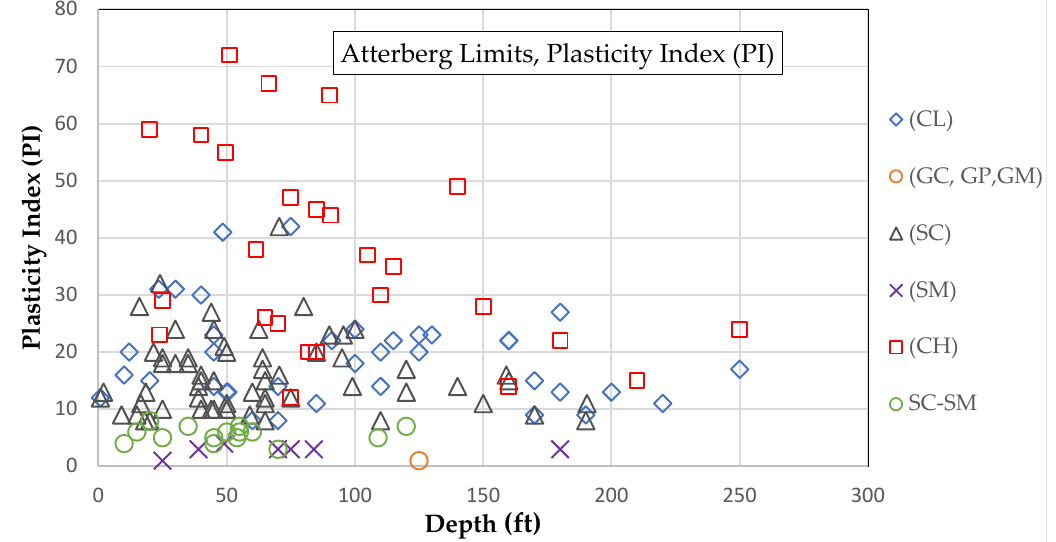
Figure 1. Measured plasticity index variation based on the depth values in the project.